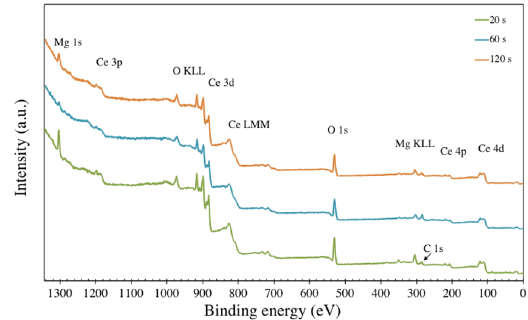
Figure 6. XPS survey spectra of the cerium-coated AZ91D alloy.